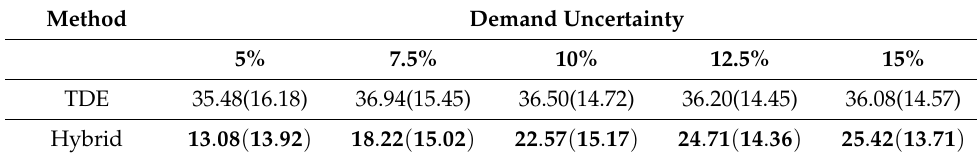
Figure 8. Comparing Computational Cost. Table 4. Comparing Computational